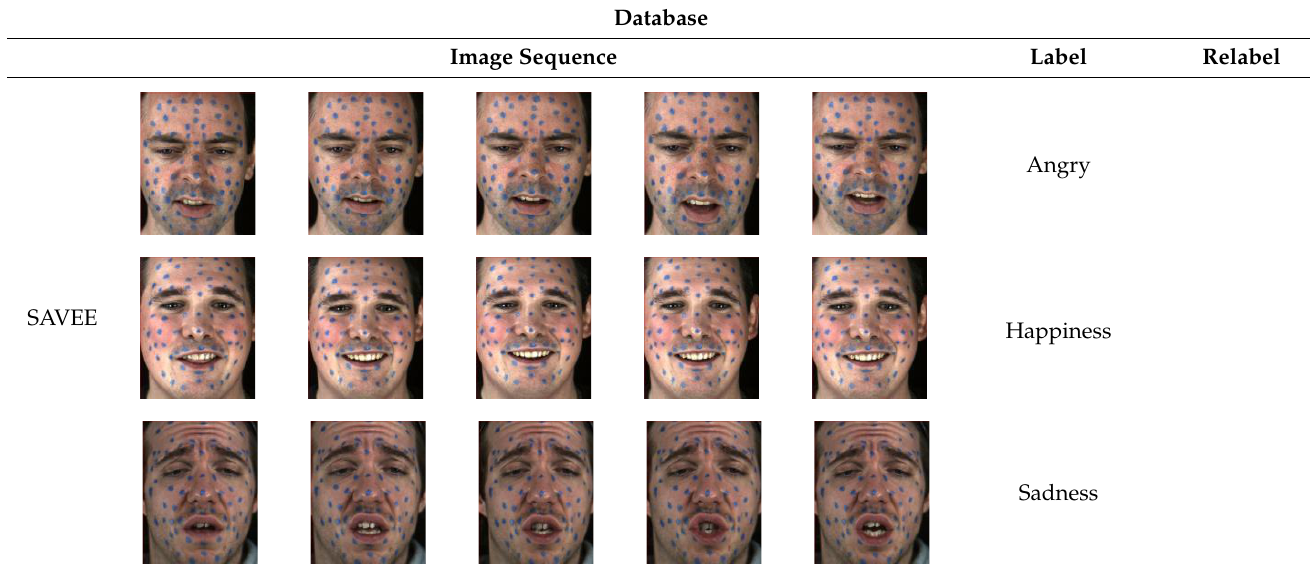
Table A1. The face part of the GEMEP database.